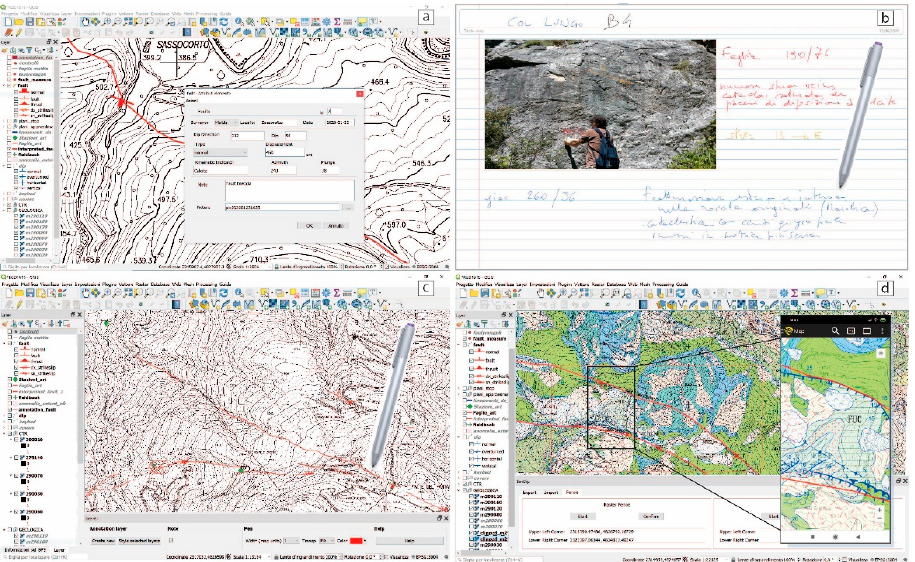
Figure 6. Software and plug-in for the field work. ( a ) Input form for fault data in QGIS, created using Qt Designer; ( b ) Windows Journal used as a field book for data collection, sketching, and photo interpretation; ( c ) BeePen, a QGIS plug-in for directly drawing on the base map with the stylus; ( d )